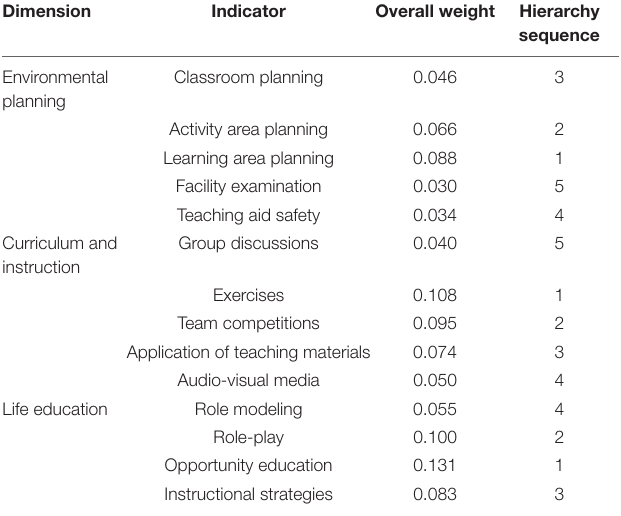
TABLE 2 | Weights in Hierarchy 3.